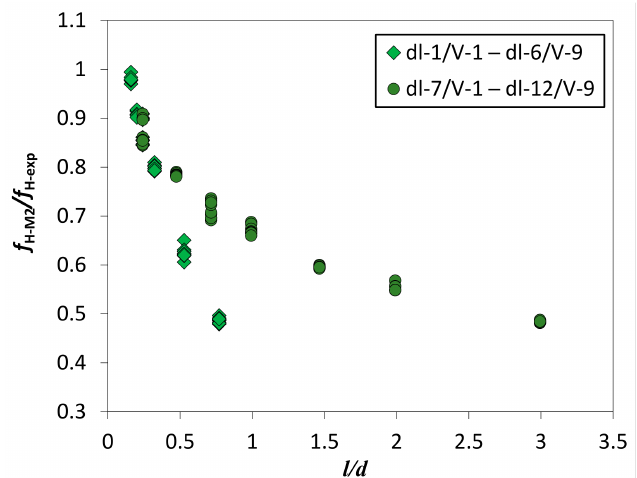
Figure 11. The ratio of frequencies obtained from the M2 model to the experimental results as a function of l/d